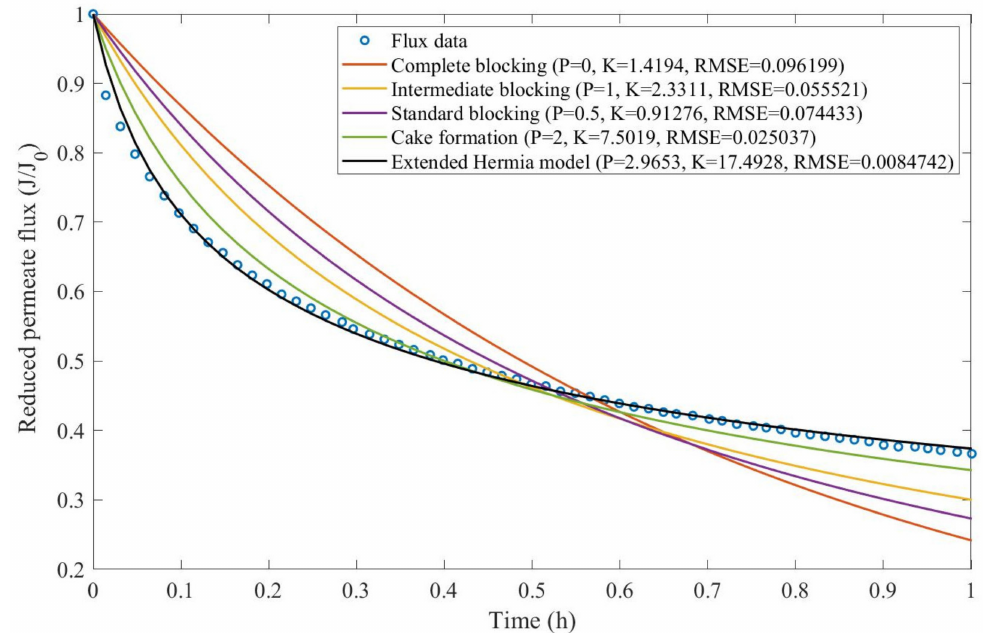
Figure A8. Model fitting for MIEX 12 mL/L + Coagulant 40 mg/L + HPO ultrafiltration considering the four original pore-blocking mechanisms and the extended Hermia model (14). Example 2: